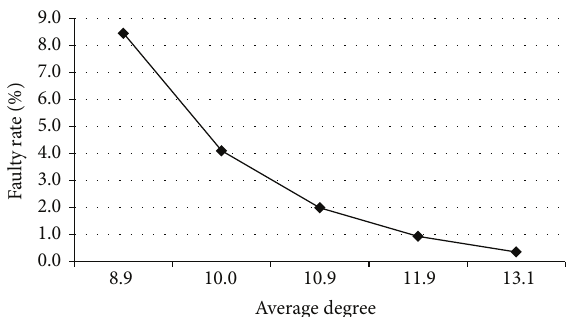
Figure 11: Faulty rate versus average degree.